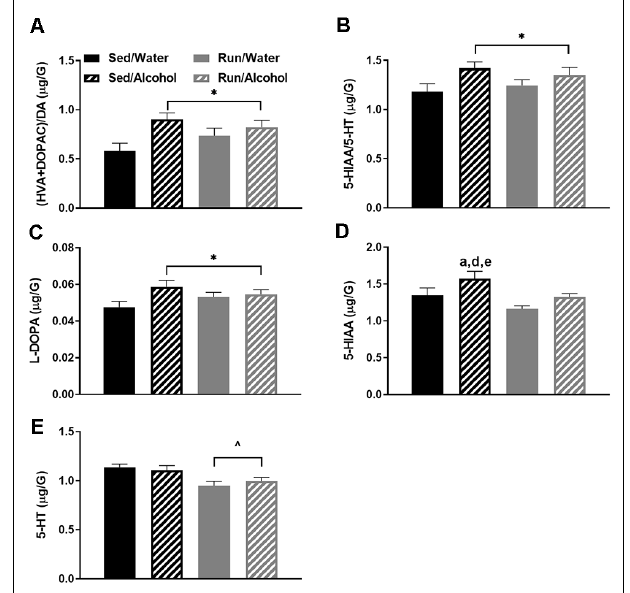
FIGURE 4 | Neurochemical levels in the mouse hypothalamus area immediately following the final DID session. 5-HT concentrations (A) , 5-HIAA concentrations (B) , NE concentrations (C) , ratio of (HVA + DOPAC)/DA (D) , and DOPAC concentrations (E) . Animals that ran and were exposed to DID had increased DOPAC levels (E) . Data represent means +SEM. ∗ P < 0.05 main effect alcohol access, ∧ P < 0.05 main effect physical activity status, b P < 0.05 Sed/Water from Run/Water, d P < 0.05 Sed/Alcohol from Run/Water, f P < 0.05 Run/Water from Run/Alcohol.